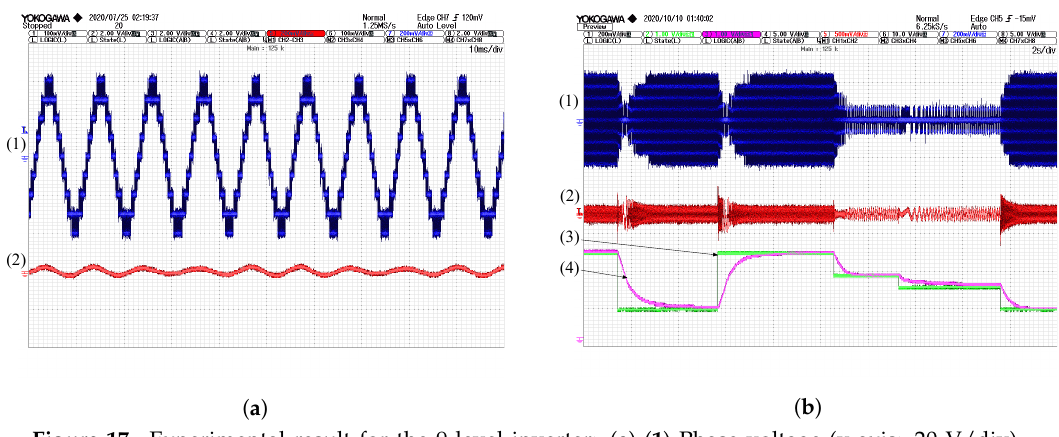
Figure 17. Experimental result for the 9-level inverter: ( a ) ( 1 ) Phase voltage (y-axis: 20 V/div), ( 2 ) phase current (y-axis: 2 A/div). ( b ) ( 1 ) Phase voltage (y-axis: 20 V/div), ( 2 ) phase current (2 A/div), ( 3 ) speed reference (y-axis: 1820 RPM/div), ( 4 ) speed feedback (y-axis: 1820 RPM/div).